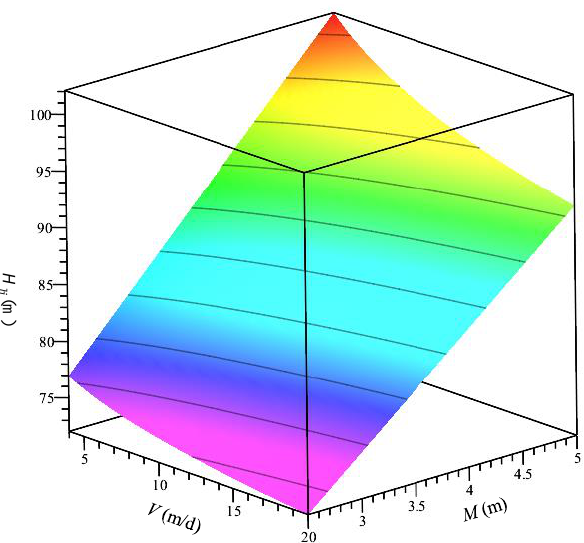
Figure 2. Influence characteristics of two factors in the prediction equation of DHWF in Selian Coal Mine.